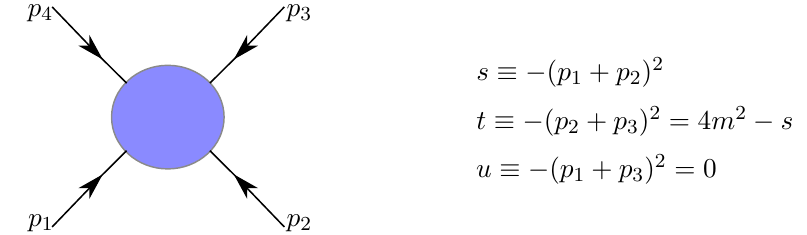
Figure 1. In two-dimensional 2 → 2 scattering, energy-momentum conservation leaves the center of mass energy squared s as the only kinematic